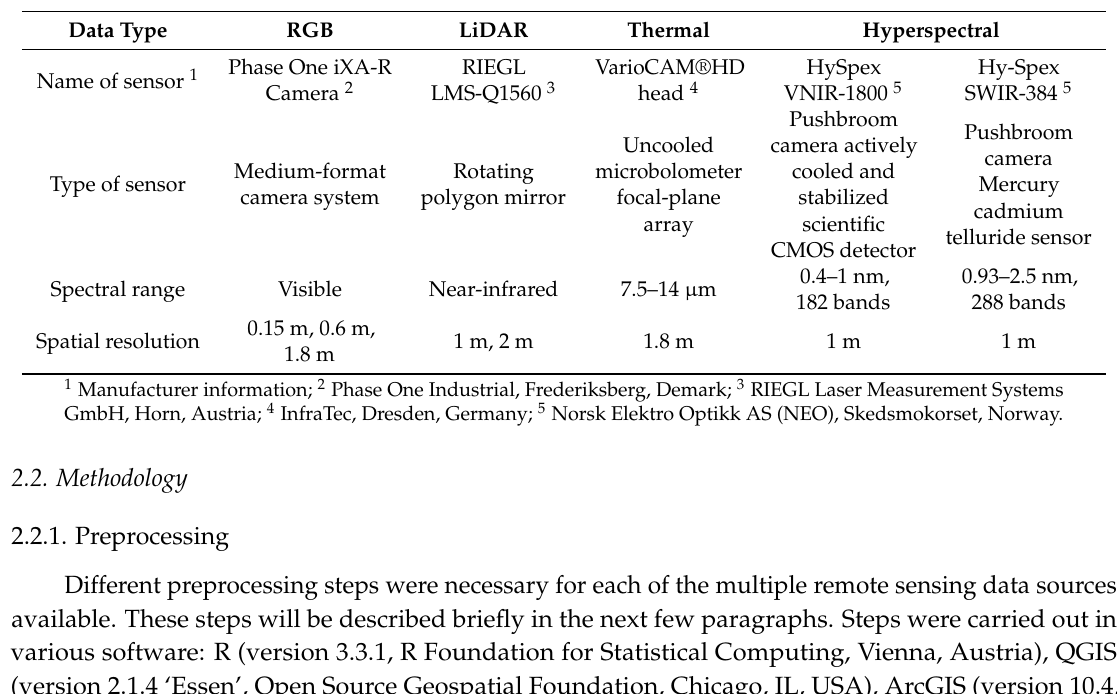
Table 1. Characteristics of the four sensor systems used for data